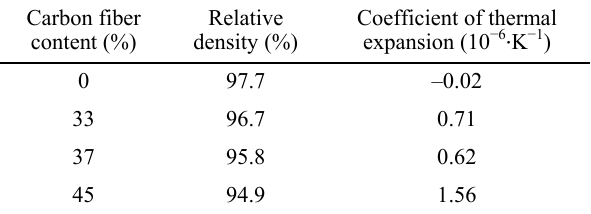
of C f /LAS composites with different carbon fiber content.